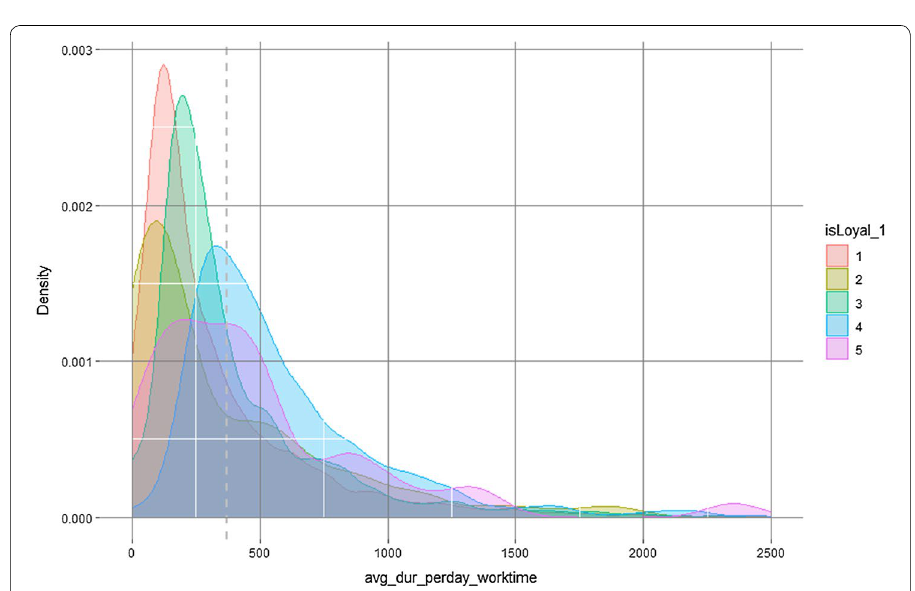
Fig. 7 Mass distribution for “Avg dur per day